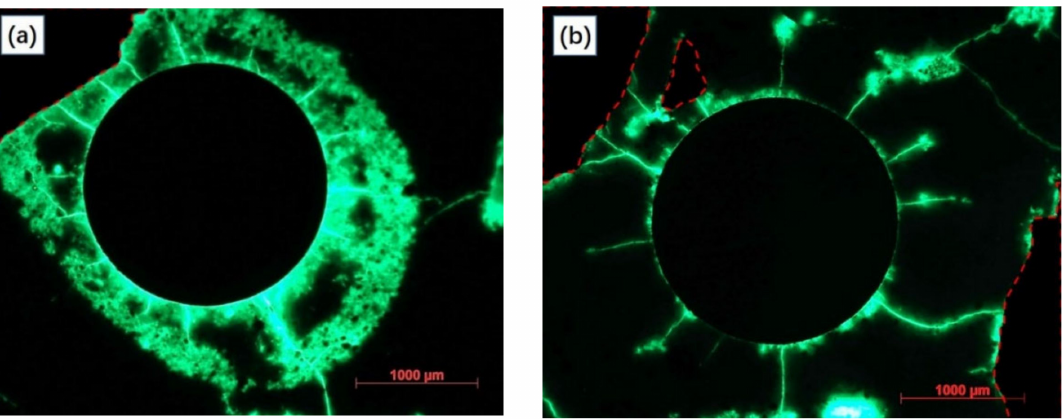
Figure 10. The fluorescence micrograph of anode samples with the maximum ( a ) or minimum ( b ) average growth rate of the equivalent diffusion